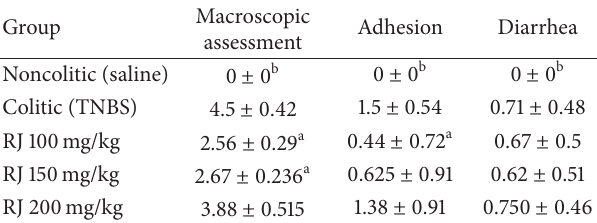
Table 1: Effect of royal jelly on the disease activity index of mice undergoing TNBS-induced colitis.